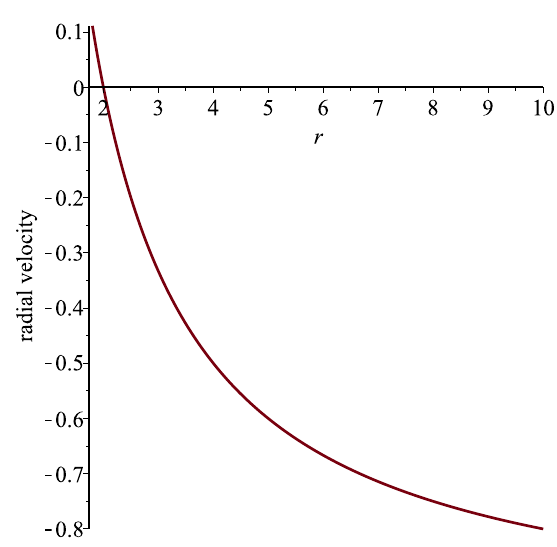
Figure 3. Behaviour of ˙ r for null geodesics in the Schwarzschild geometry when using Schwarzschild curvature coordinates for m = 1 and (cid:101) → ∞ . Note the curve crosses the r axis only at r = 2, and the coordinate velocity is negative all the way from the horizon to spatial infinity.